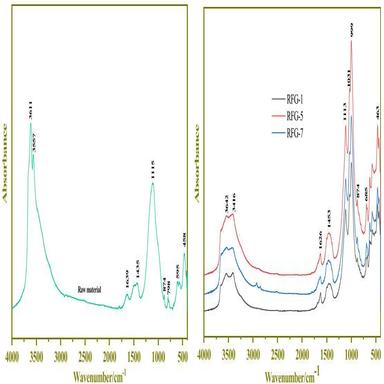
MIR spectra of mixed raw materials and samples RFG-1, RFG-5 and RFG-7 after 7d hydration.